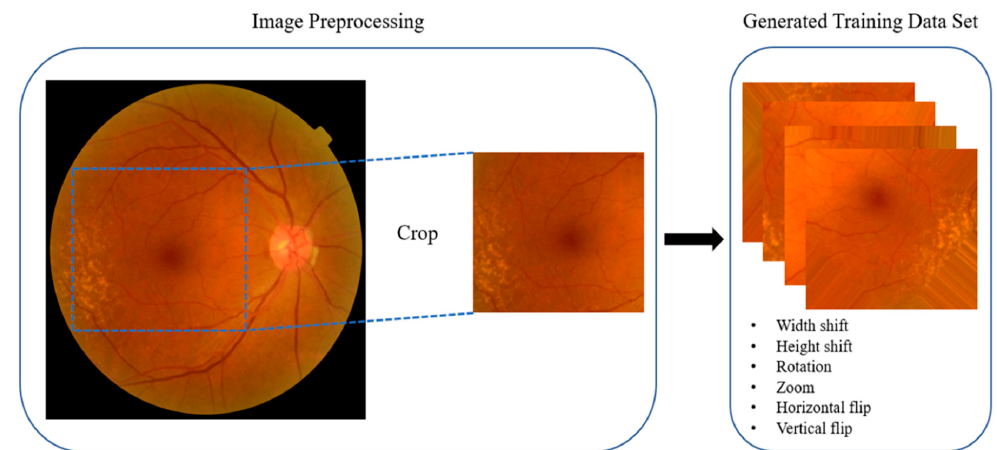
Figure 4. Image preprocessing. Eye images were preprocessed by Keras ImageDataGenerator. Original images were cropped and resized to 244 × 244 pixels. The training dataset images were generated using various methods, including width shift, height shift, rotation, zoom, horizontal flip, and vertical flip.